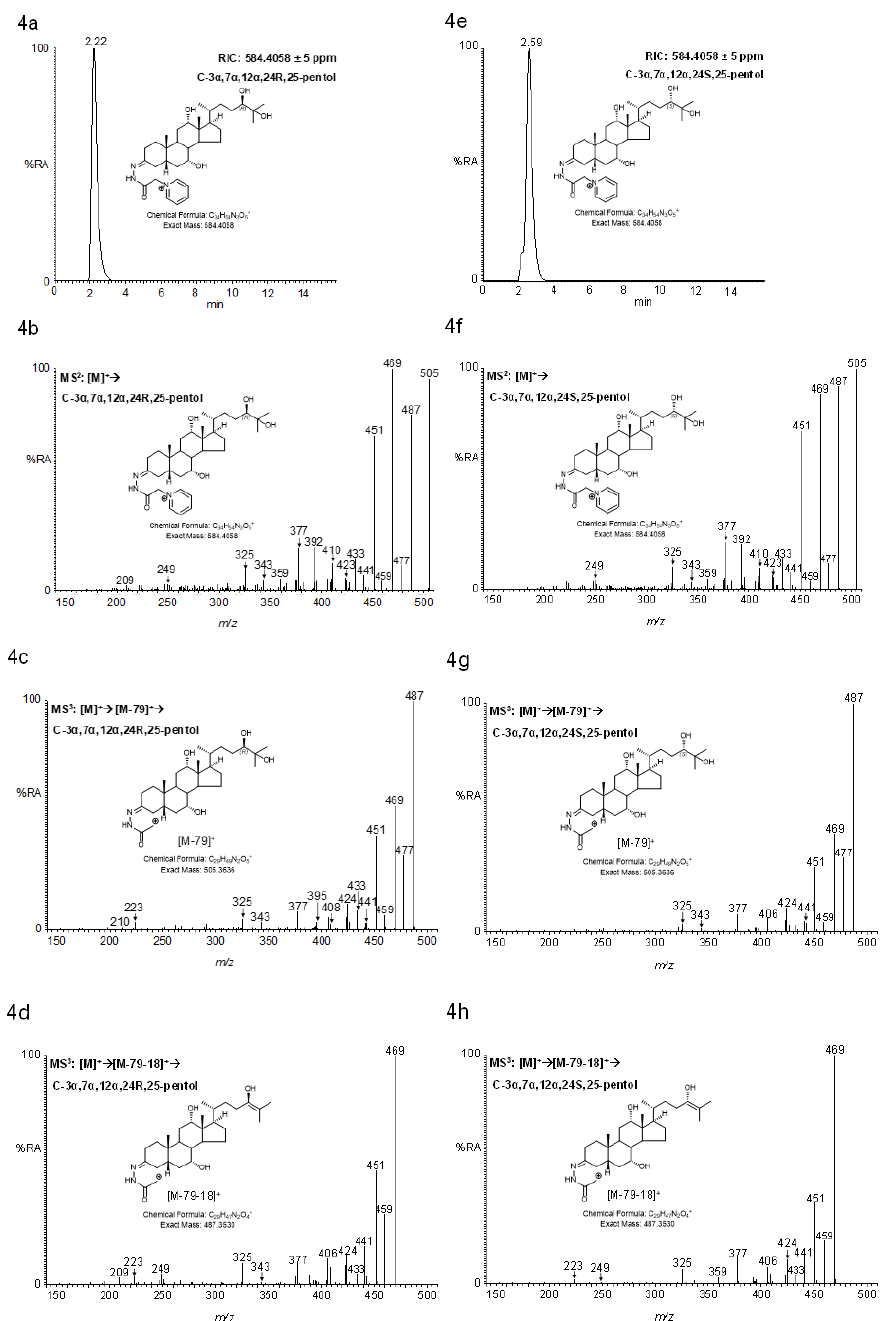
Figure 4. LC – (MS)MS n analysis of oxidized/GP-derivatized C-3 α ,7 α ,12 α ,24R,25-pentol and C- 3 α ,7 α ,12 α ,24S,25-pentol: ( a ) RIC, ( b ) MS 2 ([M] + → ), ( c ) MS 3 ([M] + → [M-Py] + → ), and ( d ) ([M] + → [M-Py- C-3 α ,7 α ,12 α